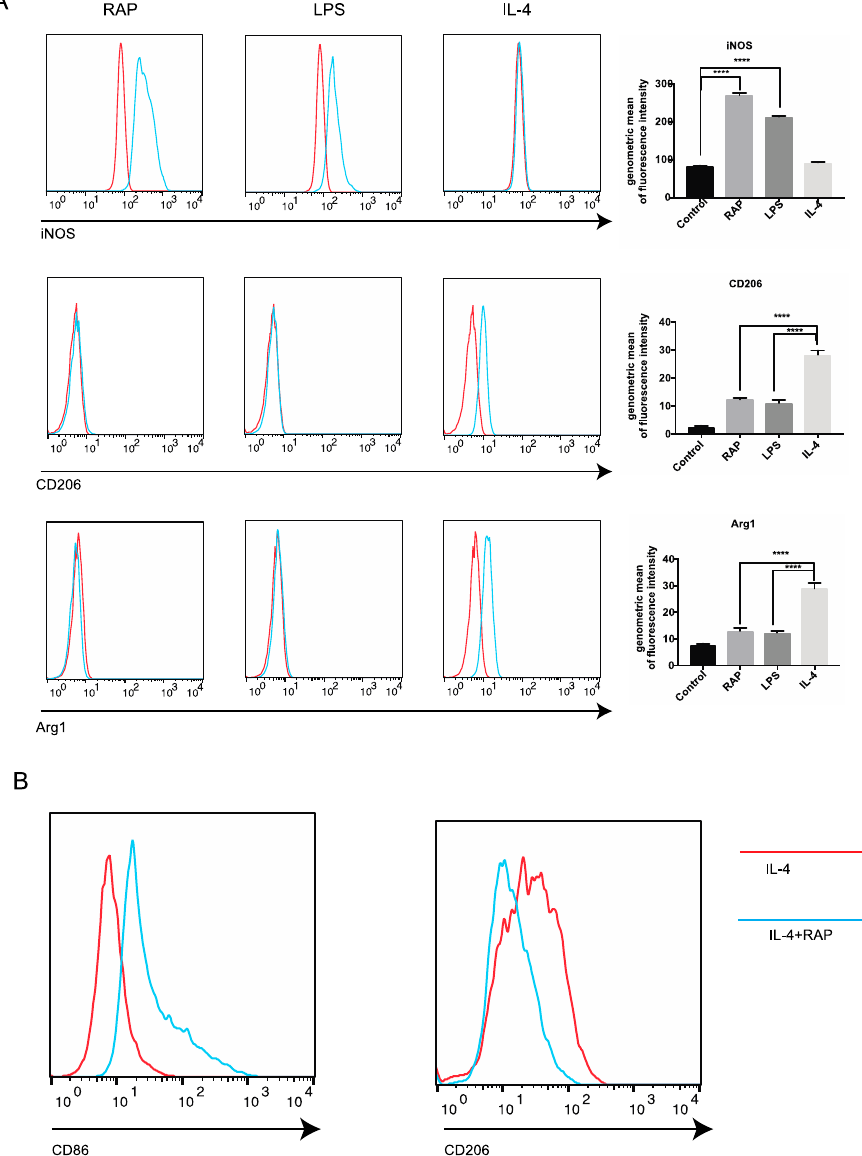
Figure 4. Analysis of expression of surface molecules on BMDMs by FCM. The BMDMs were stimulated with RAP, LPS and IL-4 for 24 h, then iNOS, CD206, and Arg1 expression level on BMDMs was determined by FCM ( A ). The statistical analysis of the expression of membranous molecules in the RAP group versus that in the control group was showed using Graphpad Prime. Columns, the percentage of the mean of three replicates; bars, SD ( A ). CD86 and CD206 expression on BMDMs stimulated with IL-4 or IL-4 plus RAP was analyzed by FCM ( B ). A significant difference of each gene expression in each group was observed by one-way ANOVA test, **** p < 0.0001.